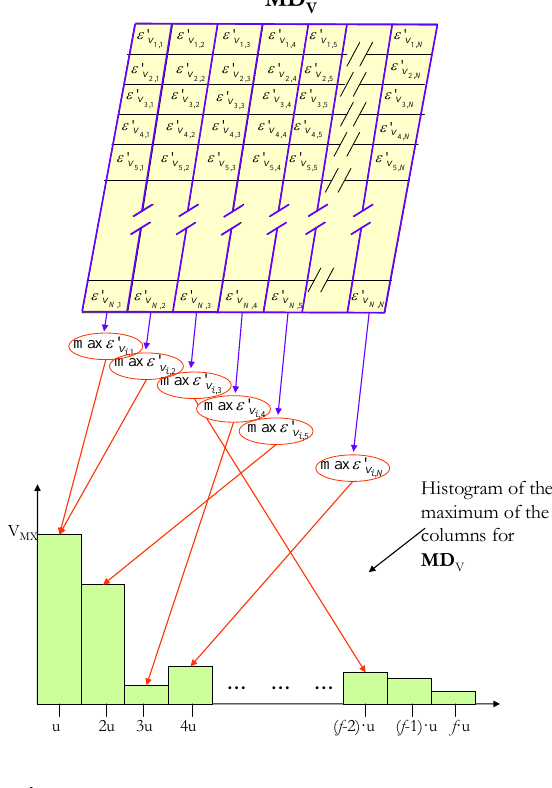
Figure 6. Example of histogram construction of the maximum of the columns for an average map of distances ( MD V